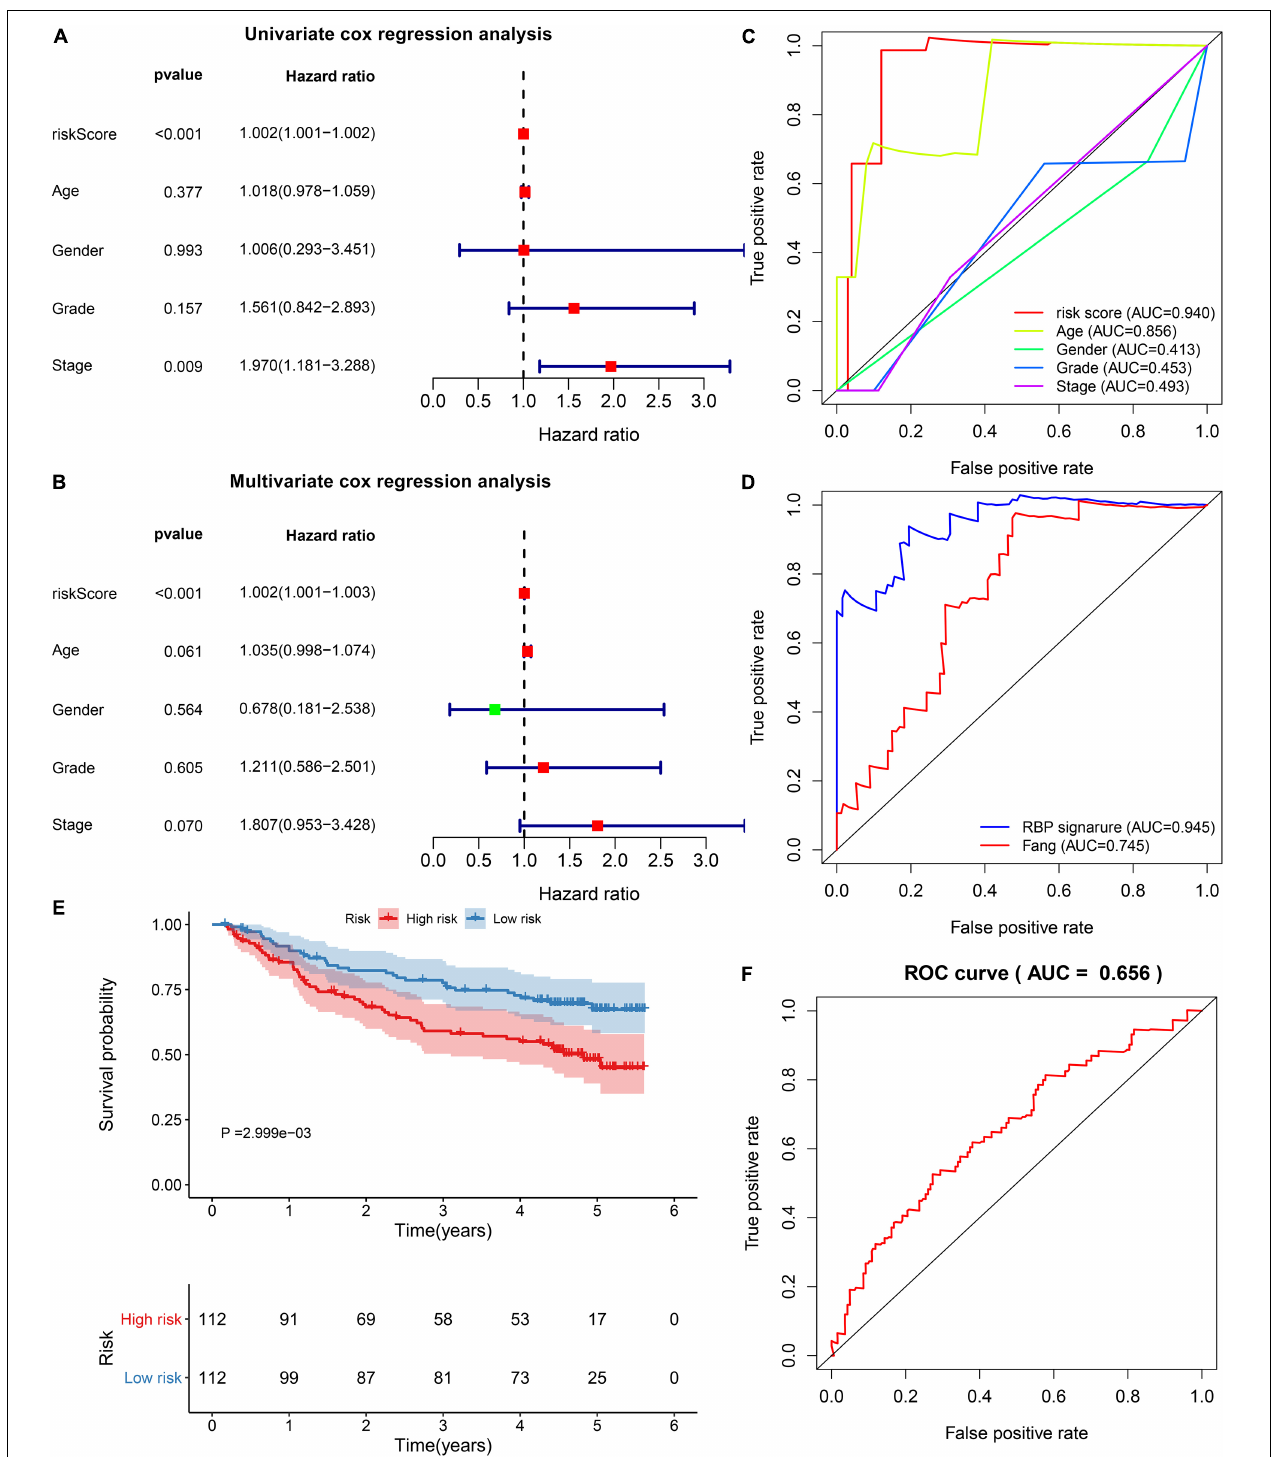
FIGURE 3 | Verification of the independency and accuracy of the prognostic model. (A) Univariate and (B) multivariate cox regression analyses of risk score, age, gender, grade, and stage with HBV-related HCC patients in the TCGA dataset. (C) The ROCs for comparing the AUCs of the risk score with age, gender, grade, and stage. (D) The ROCs for comparing the AUCs of the risk score with the model constructed by Fang et al. (E) Survival differences between high- and low-risk patients in the GSE14520 dataset. P value was estimated with log-rank test. (F) The ROC for evaluation of the predictive performance of the risk score.